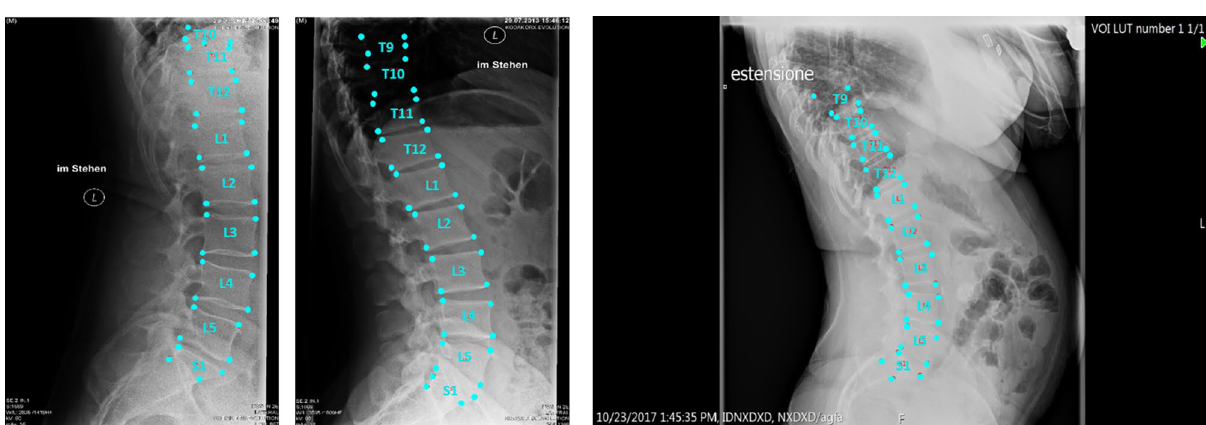
Figure 4. Examples of images hard to understand also for a human observer. In the first image, the model does not find the correct coordinates of T10 since the vertebra is cropped. In the second image, the top part is black making distinguishing a vertebra impossible. In the third image, the brightness is too high to localize correctly the vertebrae at the